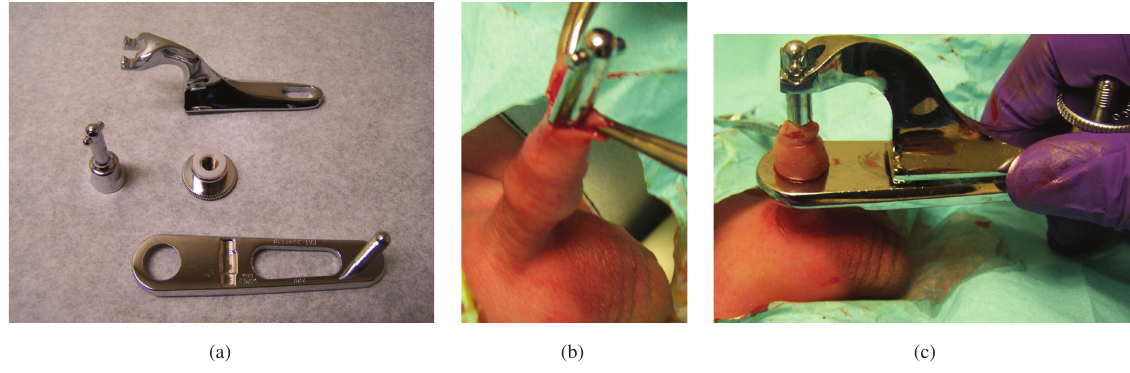
FIGURE 1: (a) The Gomco clamp consists of 4 pieces: the bell, platform, hooking arm, and screw. These are assembled after placing the bell completely over the glans (b) and the skin drawn through the hole in the platform. Hemostasis is obtained by tightening the screw (c) and the skin excised.